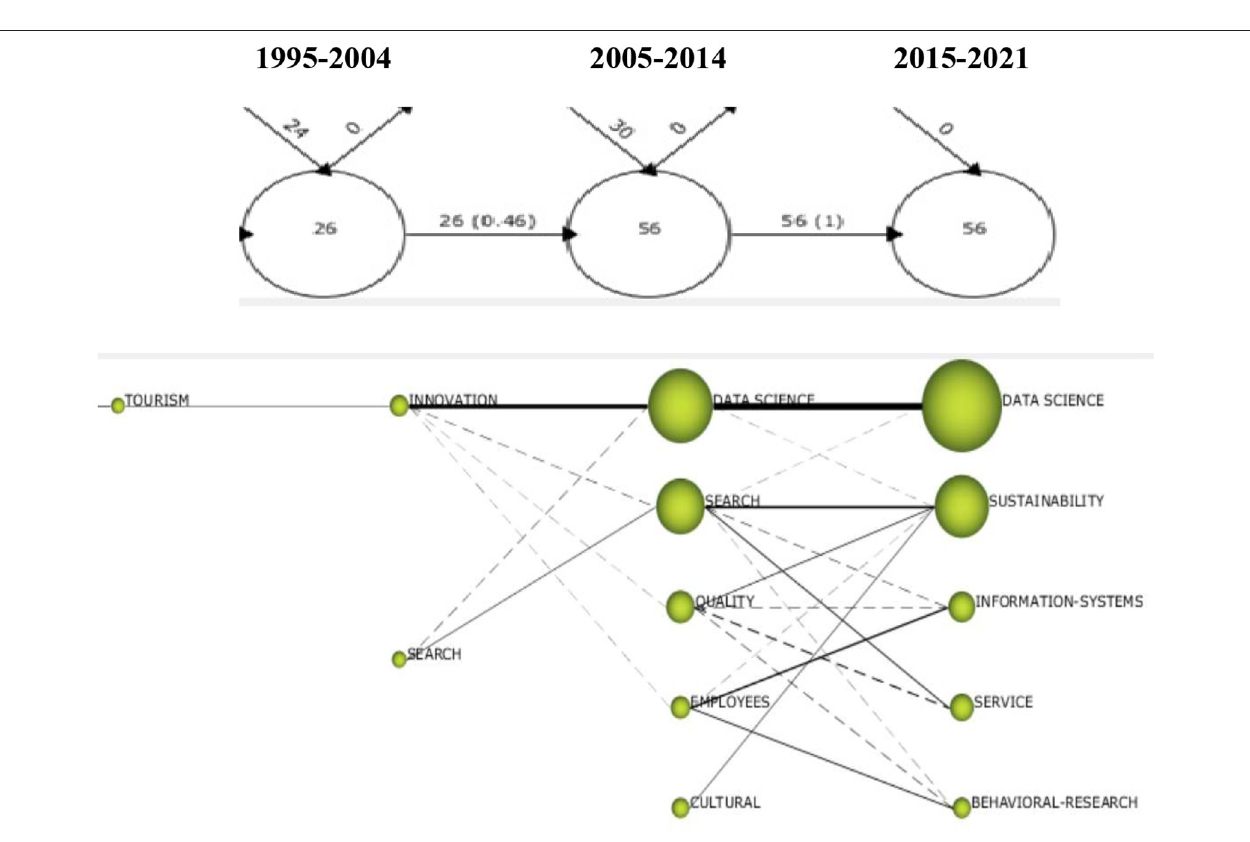
Frontiers in Psychology |